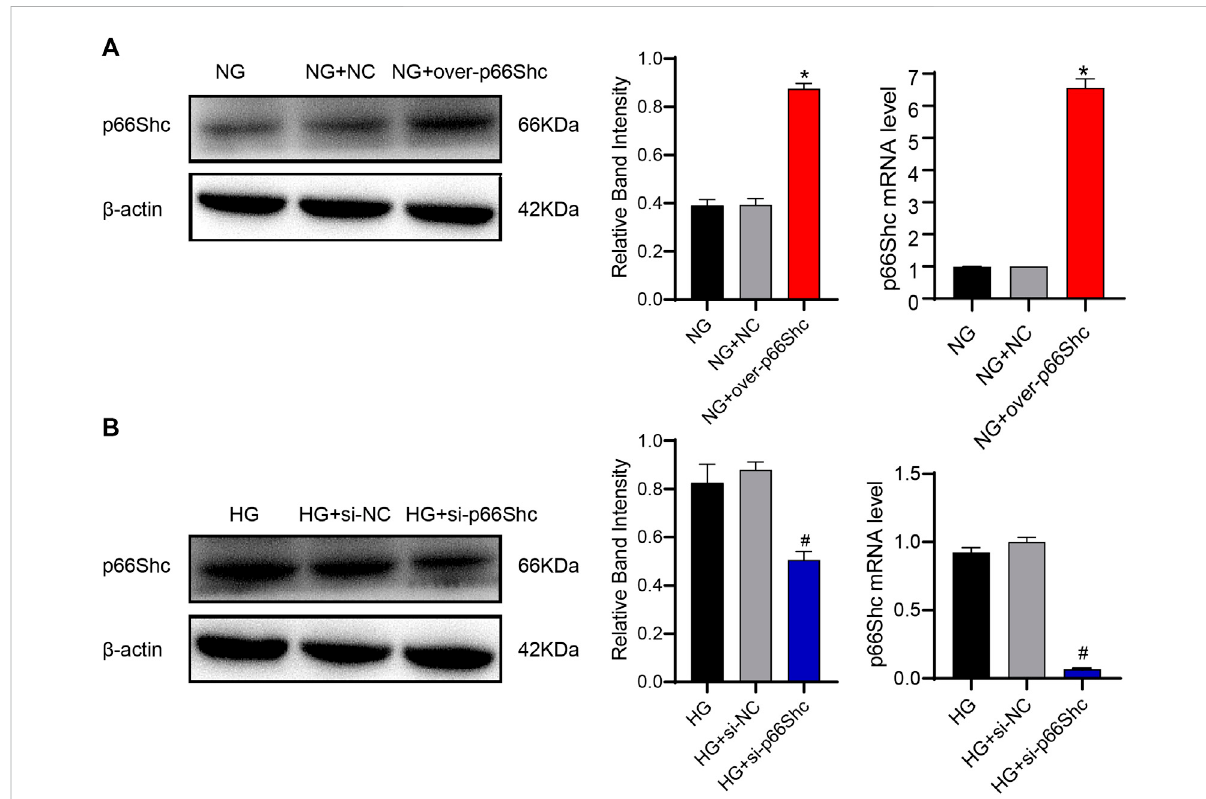
FIGURE 7 (A) Transfection ef fi ciency of over-p66Shc was determined by qRT-PCR and western blotting assay. Mean ± SD. n = 3. p p < 0.05 vs. NG group. (B) Transfection ef fi ciency of si-p66Shc was determined by qRT-PCR and western blotting assay. Mean ± SD. n = 3. # p < 0.05 vs. HG